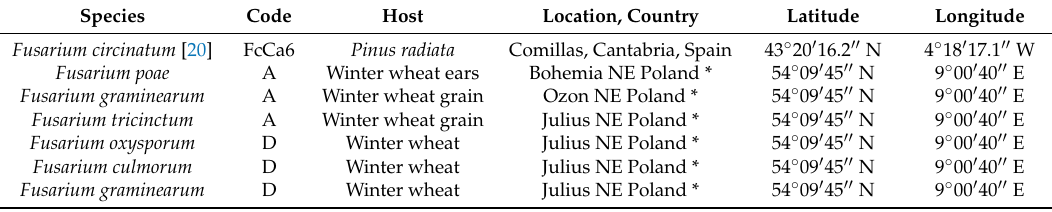
Table 1. Origin of isolates of Fusarium species used in the study.